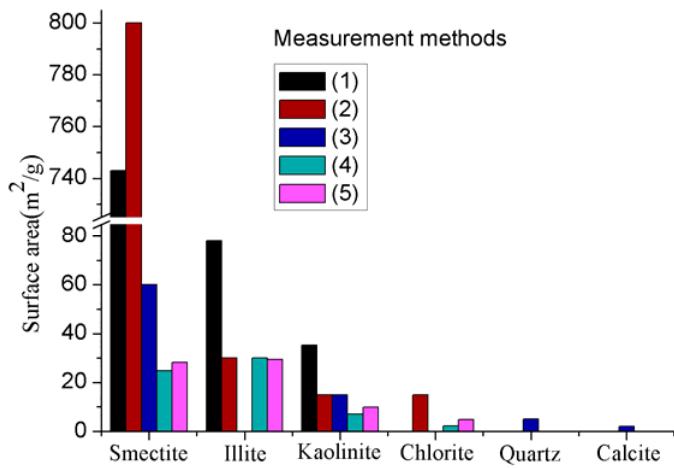
Figure 2. Comparison of surface areas of clay and some other major minerals in rock measured using various adsorption mediums: (1) Methylene blue absorption [53]; (2) Adsorption of water [52]; (3) Extrapolation from N 2 BET [13]; (4) N 2 BET surface area [14]; (5) CO 2 equivalent surface area [14].